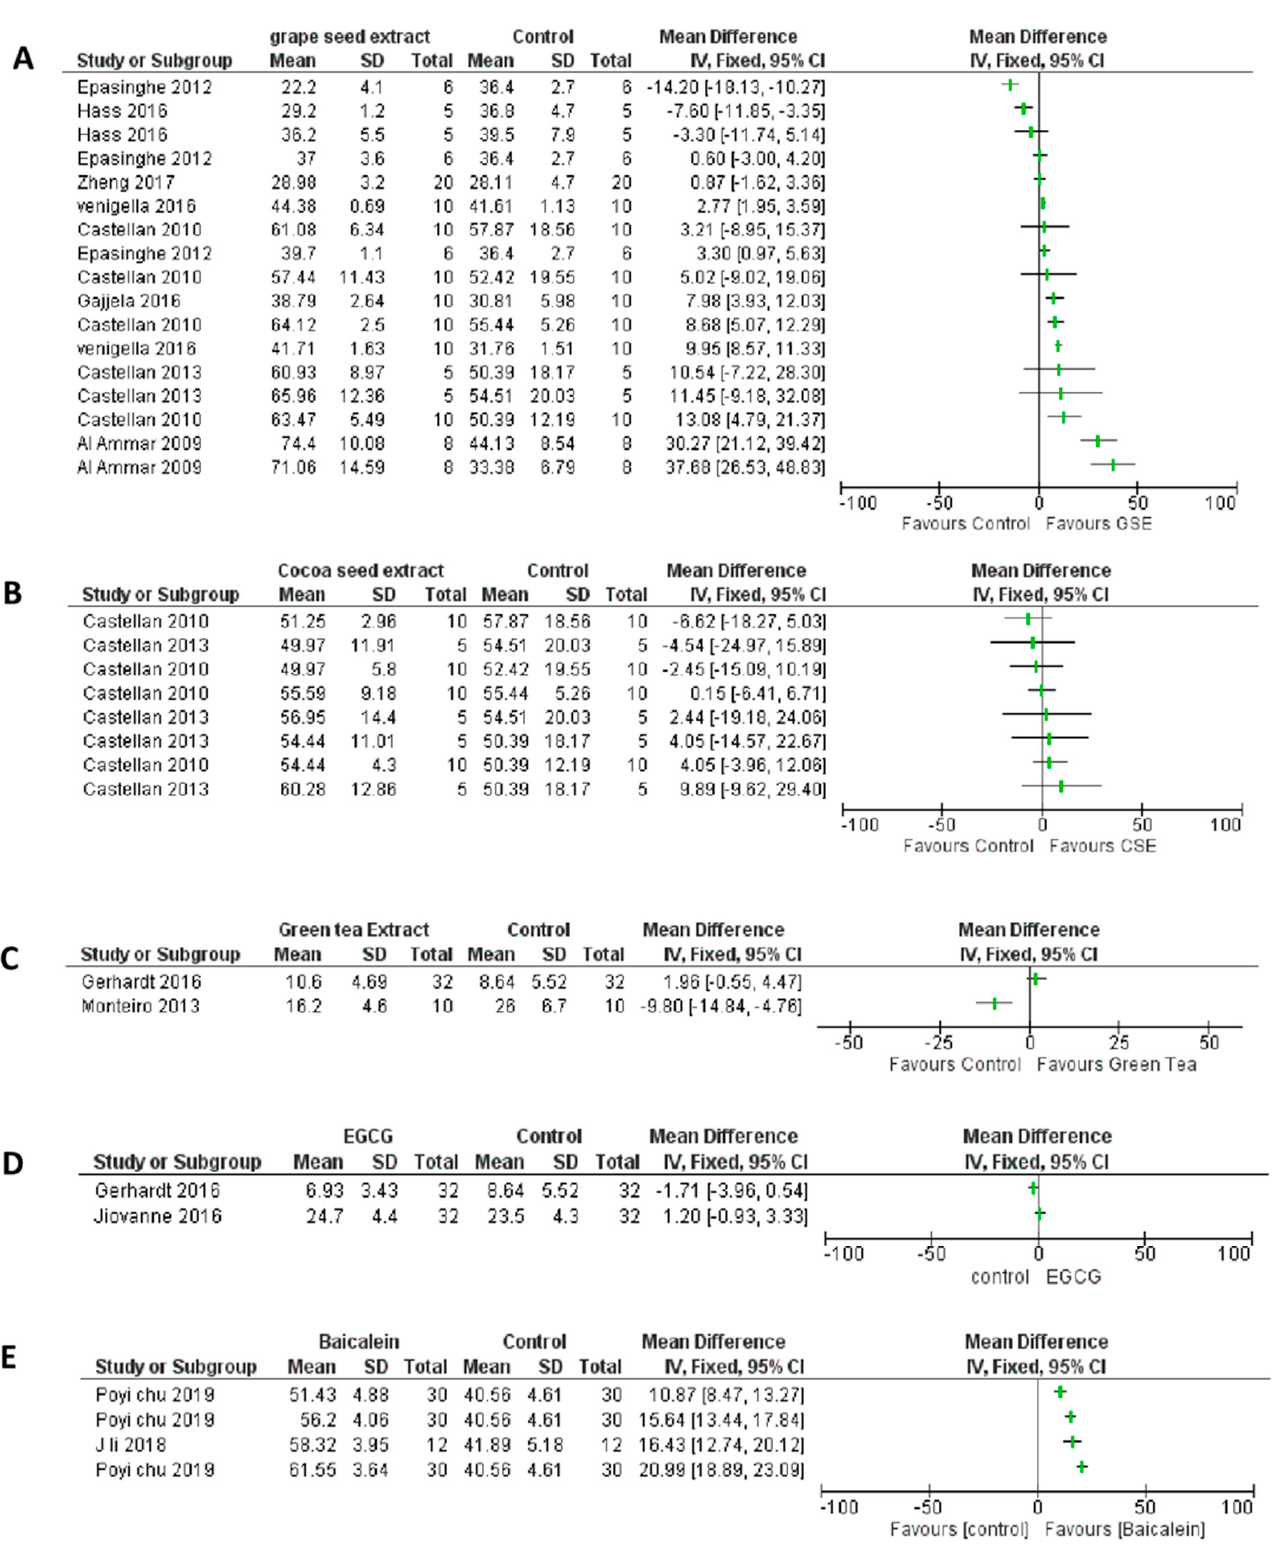
Figure 2. Forest plot analysis of studies at baseline (No ageing). ( A )—Proanthocyanidin (PA)/Grape seed extract (GSE) vs. control at baseline. ( B )—Cocoa seed extract (CSE) vs. control at baseline. ( C )—Green tea extract (GTE) vs. control at baseline. ( D )—Epigallocatechin gallate (EGCG) vs. control at baseline. ( E )—Baicalein vs. control at baseline.